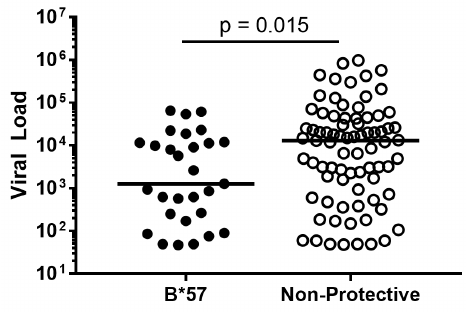
Figure 1. Association of B*57 with viral control in 1917 clinic cohort. Viral loads of 1917 clinic patients with protective HLA-B*57 allele versus those of patients lacking any HLA-I alleles previously associated with delayed or accelerated disease